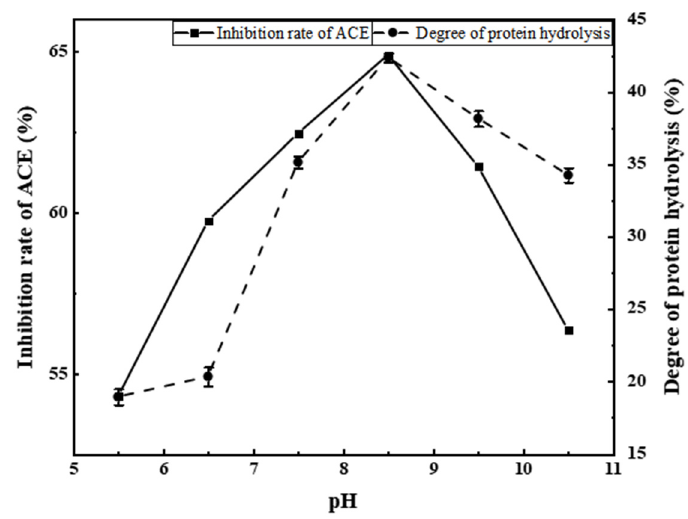
Figure 4. Effect of pH on the inhibition rate of ACE and the degree of protein hydrolysis.